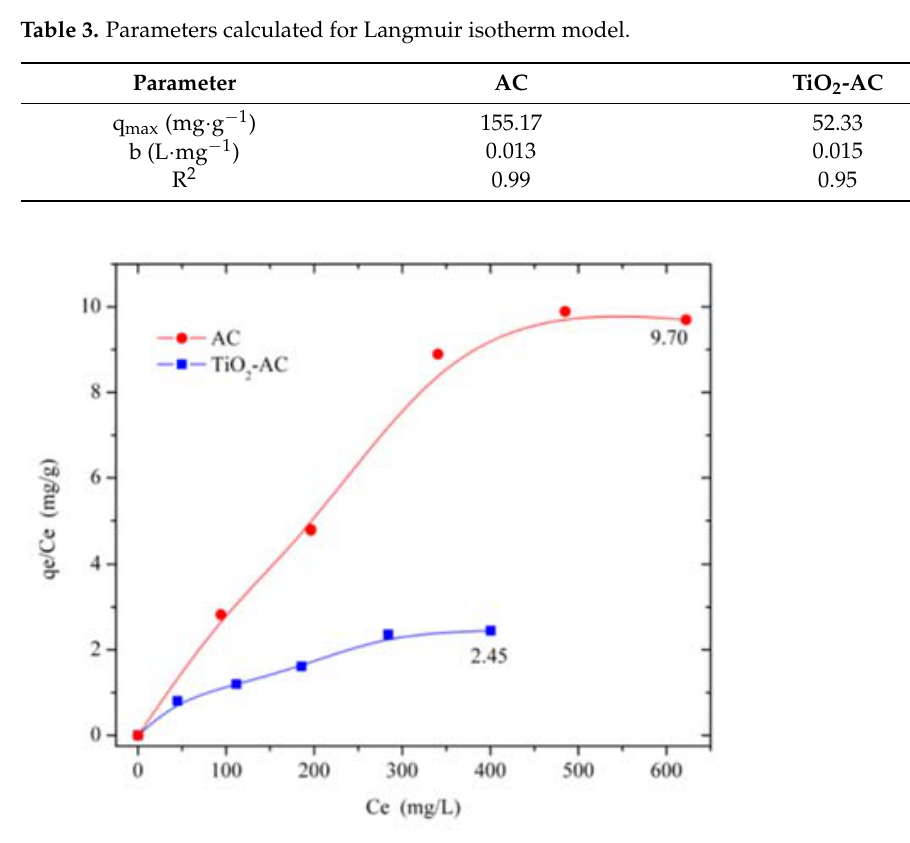
Table 3. Parameters calculated for Langmuir isotherm model.